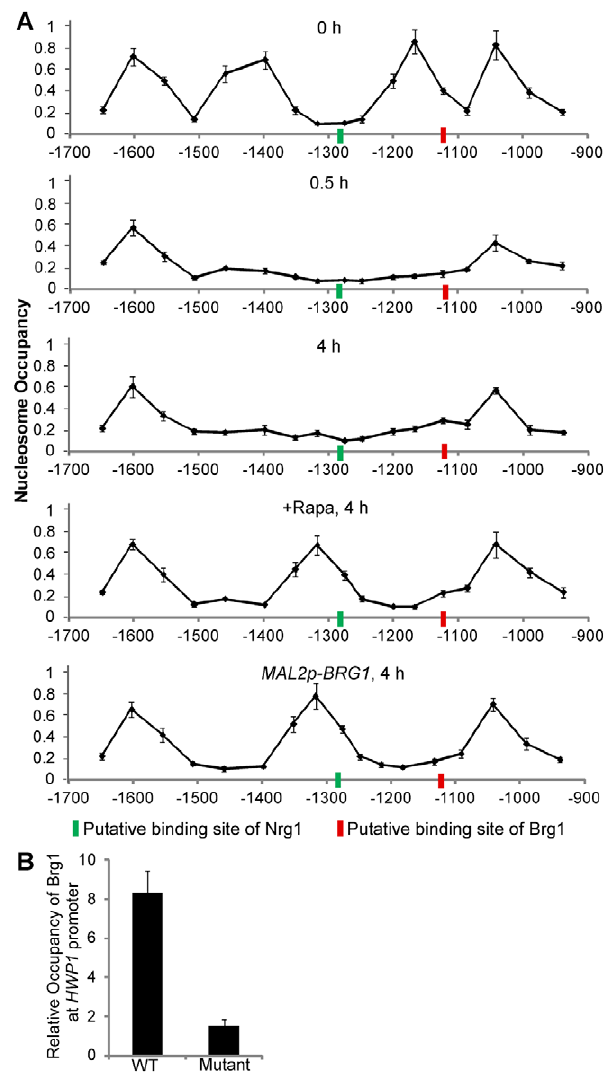
Figure 5. Nucleosome mapping analysis at the UAS region of the HWP1 promoter indicates different promoter accessibility to Nrg1 and Brg1 in yeast and hyphal cells. Overnight cultures of wild type (SN250) cells were diluted 1:100 fold into YPD medium in the presence or absence of 10 nM rapamycin at 37 u C. Cells of wild type carrying MAL2p-BRG1 (HLY3636) were diluted 1:100 fold into YPMaltose medium at 37 u C. Cells were collected at indicated times and conditions for nucleosome mapping analysis. PCR primer pairs were designed to generate , 100 bp fragments, with , 60 bp overlapping and a 40 bp gap between neighboring PCR fragments. The x-axis represents the midpoints of qPCR reactions. The signals from genomic DNA from each sample for each primer pair were used for normalization. Data show the average of three independent qPCR experiments with error bars representing the SEM. Putative binding sites of Nrg1 ( 2 1284 , 2 1279) and Brg1 ( 2 1130 , 2 1125) in the UAS region of the HWP1 promoter are marked. (B). The predicted Brg1 binding motif in the UAS region of the HWP1 promoter is required for Brg1 binding. An overnight culture of HLY4079 (carrying both the WT HWP1 promoter and a copy of the HWP1 promoter mutated at the Brg1 binding site) was inoculated at a 1:100 dilution into YPD medium in the presence of 10 nM rapamycin at 37 u C for 4 h. Primers 21 and 22 were used to quantitate the binding of Brg1 to the WT HWP1 promoter over no tag control, and primers 21 and 23 were used to quantitate the binding of Brg1 to the mutated HWP1 promoter over no tag